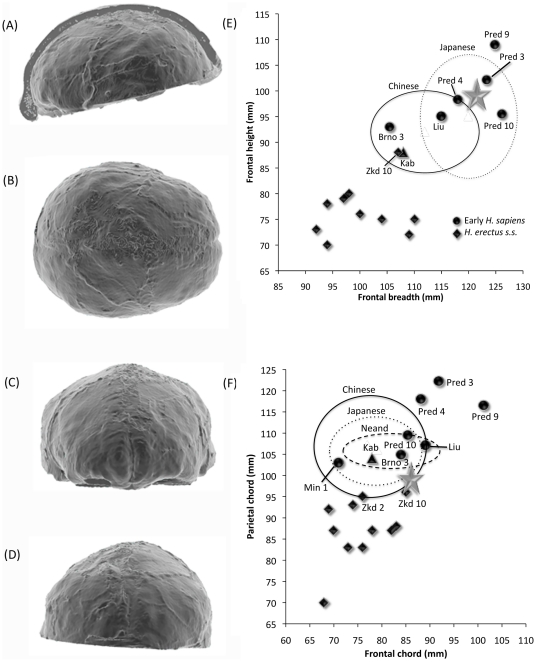
Virtual endocast of MLDG 1704.Left panel: (A) left lateral aspect, (B) superior aspect, (C) anterior aspect, and (D) posterior aspect. Right panel: (E) plot of frontal breadth versus frontal height, and (F) plot of frontal chord versus parietal chord (Gray star = MLDG 1704; ellipses are ranges for samples; Chinese = recent Chinese; Japanese = recent Japanese; Kab = Kabwe; Liu = Liujiang; Min 1 = Minatogawa 1; Nea = Neandertal Pred = Predmost; Zkd = Zhoukoudian).